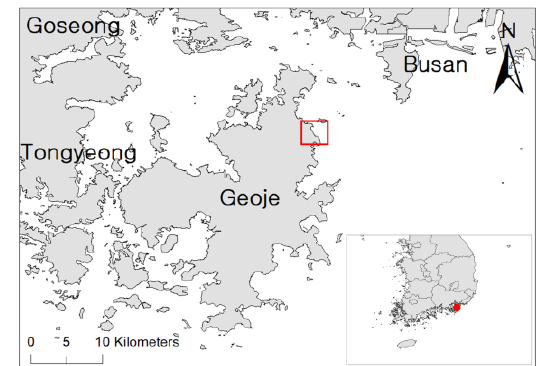
Figure 1. Study area(Heungnam beach, red box) and location of the study area in the South Korea(red